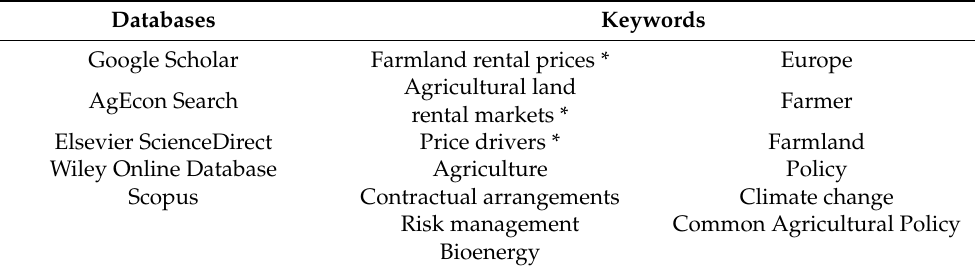
Table 1. Databases and keywords applied for the literature review.